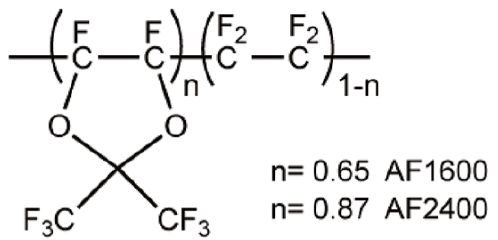
Figure 13. The structure of Teflon AF2400.